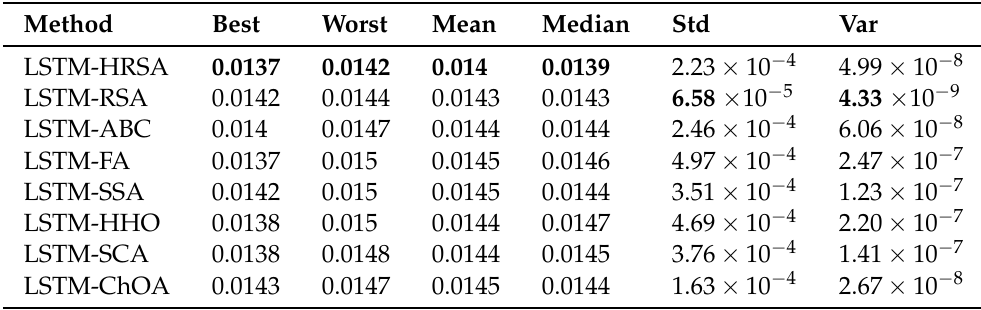
Table 1. Overall results of the objective function for LSTM experiments. The best result in each column is written in